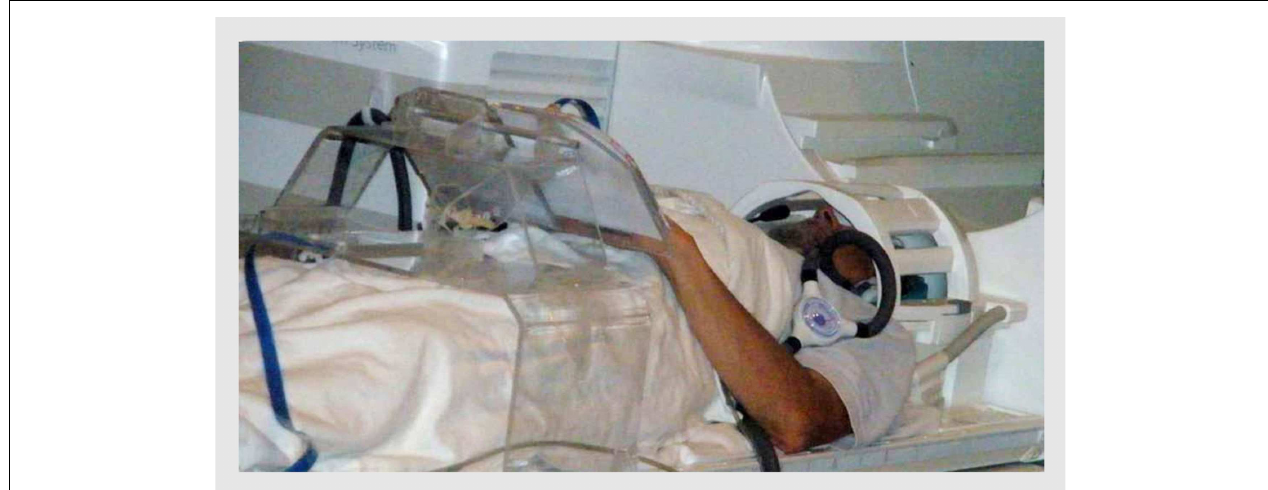
movements with high precision.The motion-capture information synchronized with the fMRI allows the effect of behavioral events to be analyzed to high